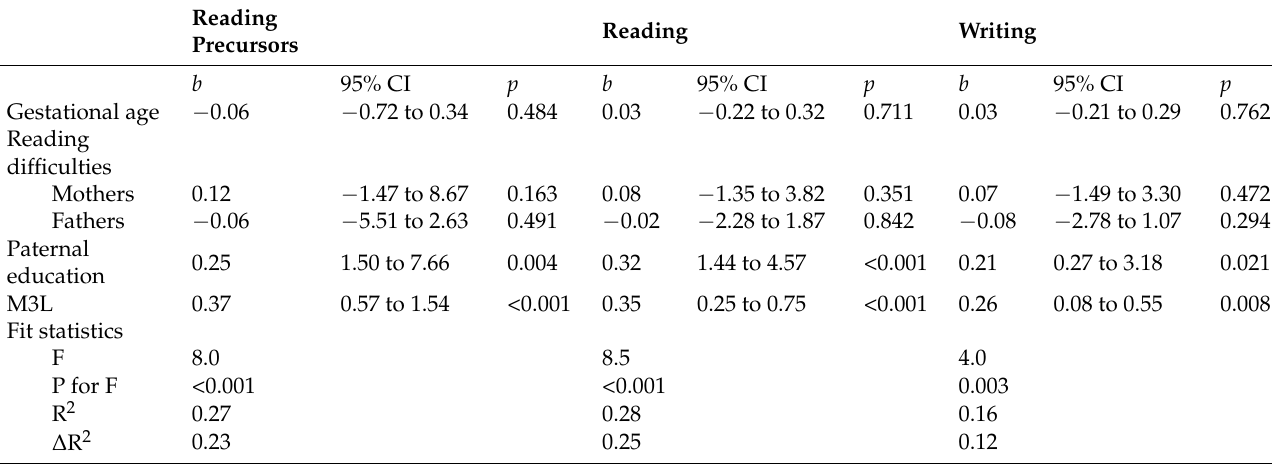
Table 6. Results of multiple variable linear regression analysis with reading precursors, reading, and writing skills at 7 years of age as dependent variables, and with M3L at 2 years of corrected age and background factors as independent variables. Results of VP/VLBW children are